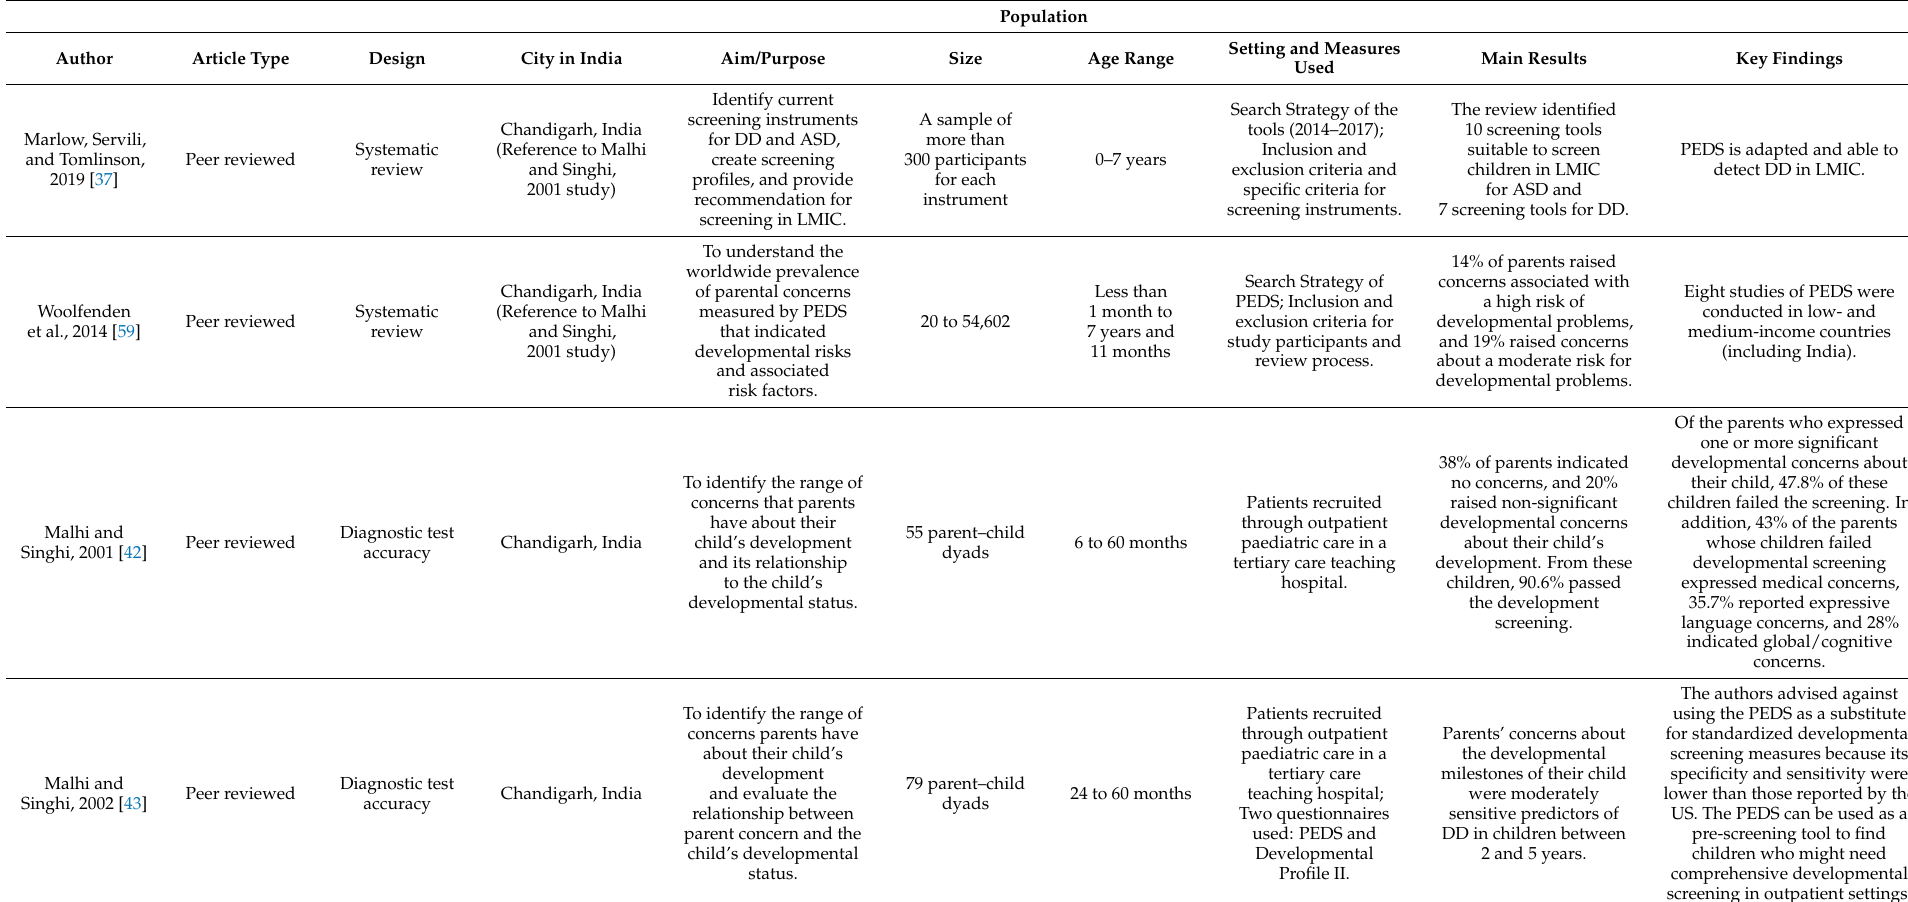
Table 1. Summary of studies on Parent Evaluation of Developmental Status (PEDS) use in